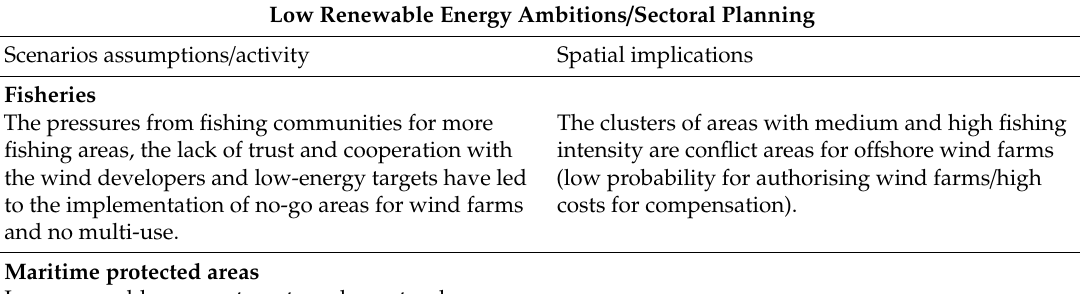
Table 10. Scenario C: Low renewable energy ambitions / sectoral planning.